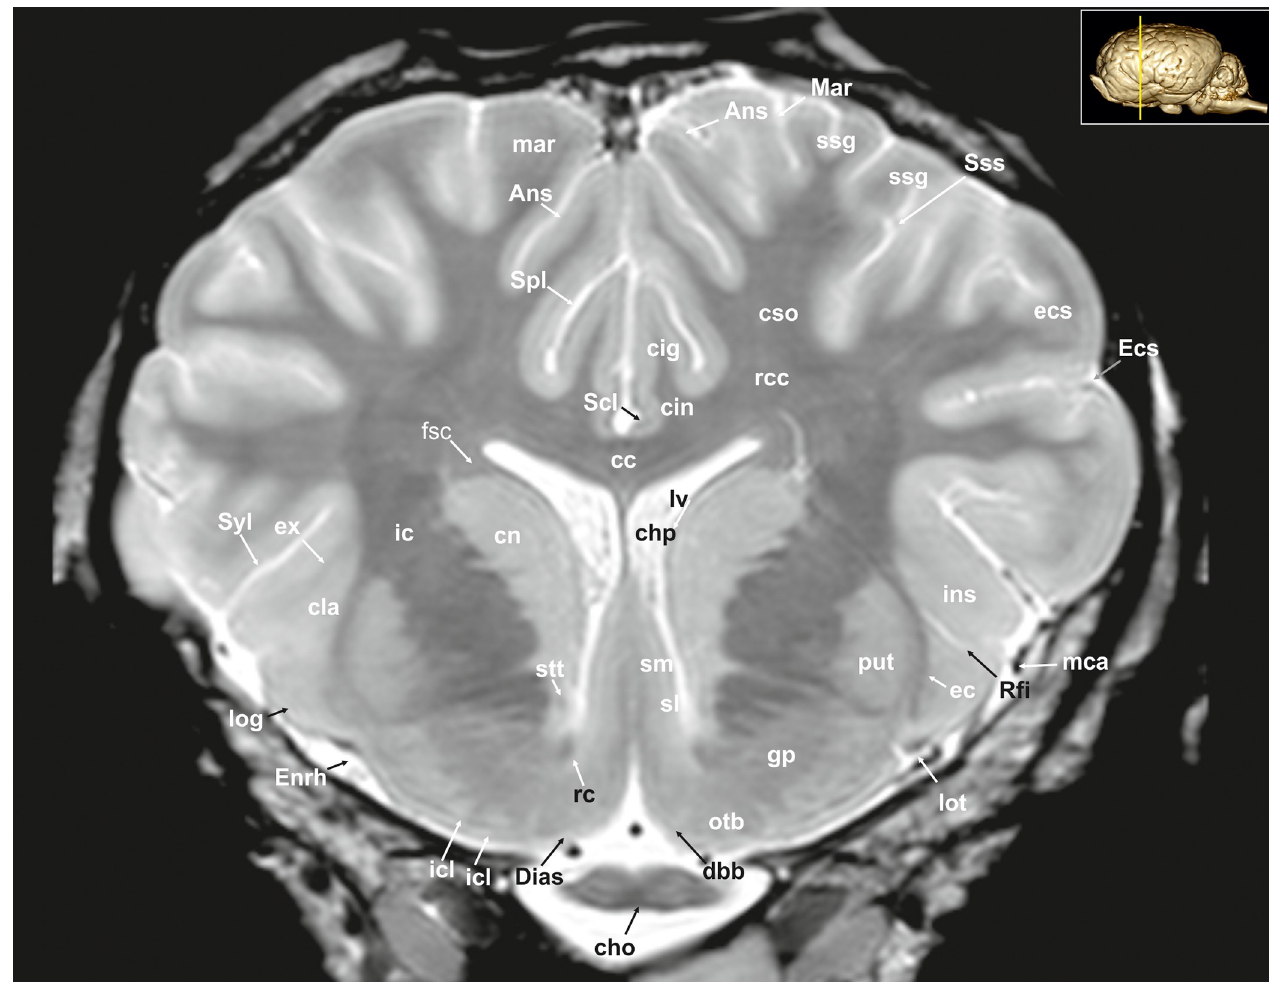
Fig 5. Transverse magnetic resonance image of the equine brain on the level of the diagonal band of Broca. Ans: ansate sulcus, cc: corpus callosum, cho: optic chiasm, chp: choroid plexus, cin: cingulum, cig: cingulate sulcus, cla: claustrum, cn: caudate nucleus, cso: centrum semiovale, dbb: diagonal band of broca, Dias: diagonal sulcus (Rhinencephalon), ec: external capsule, ecs: ectosylvian gyrus, Ecs: ectosylvian sulcus, Enrh: endorhinal sulcus, ex: extreme capsule, fsc: subcallosal fasciculus, gp: globus pallidus, ic: internal capsule, icl: islands of Calleja, ins: insular cortex, log: lateral olfactory gyrus, lot: lateral olfactory tract, lv: lateral ventricle, mar: marginal gyrus, Mar: marginal sulcus, mca: medial cerebral artery, otb: olfactory tubercle, put: putamen, rc: rostral commissure, rcc: radiation of corpus callosum, Rfi: rhinal fissure, Scl: sulcus of corpus callosum, sl: lateral septal nuclei, sm: medial septal nuclei, Spl: splenial sulcus, ssg: suprasylvian gyrus, Sss: suprasylvian sulcus, Syl: Sylvian fissure.